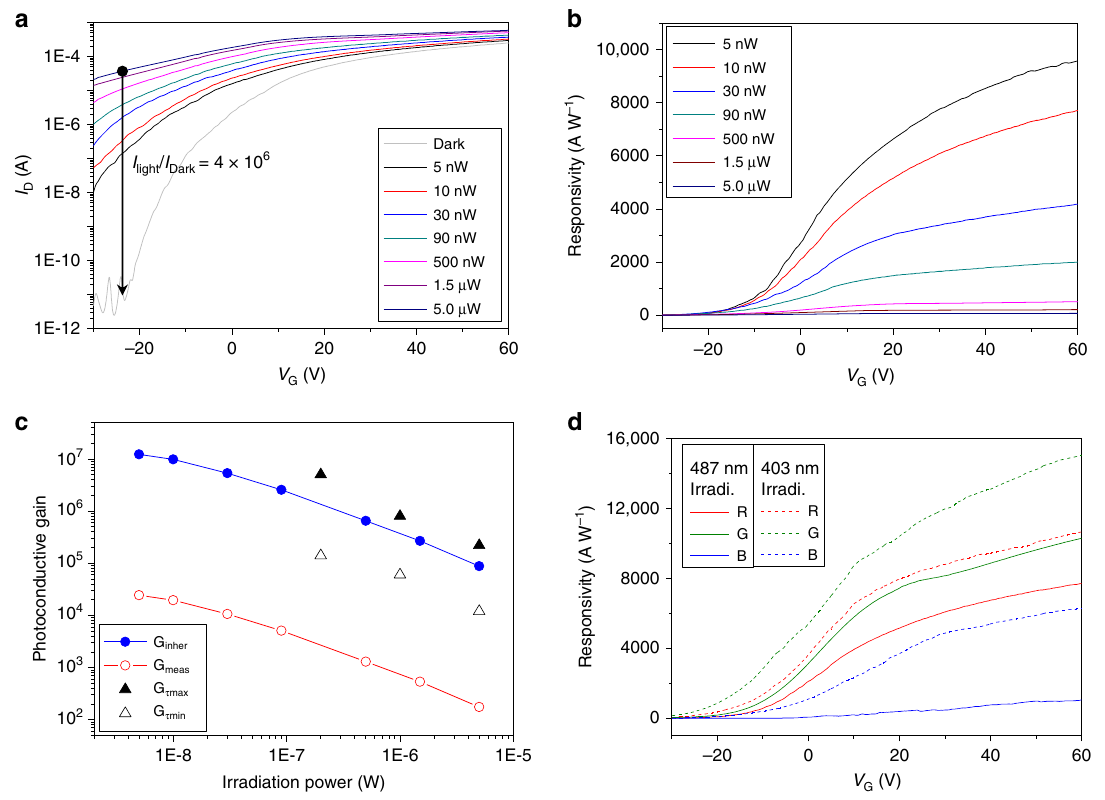
Fig. 4 Photoresponse characteristics and photoconductive gains. a Photocurrent responses and b R trends of 1RQ-OQO phototransistors with respect to incident light power. c Photoconductive gains using three different estimation methods vs. incident light power. d R trends of 1RQ-, 1GQ-, and 1BQ-OQO phototransistors at 487- and 403-nm wavelengths with 10-nW